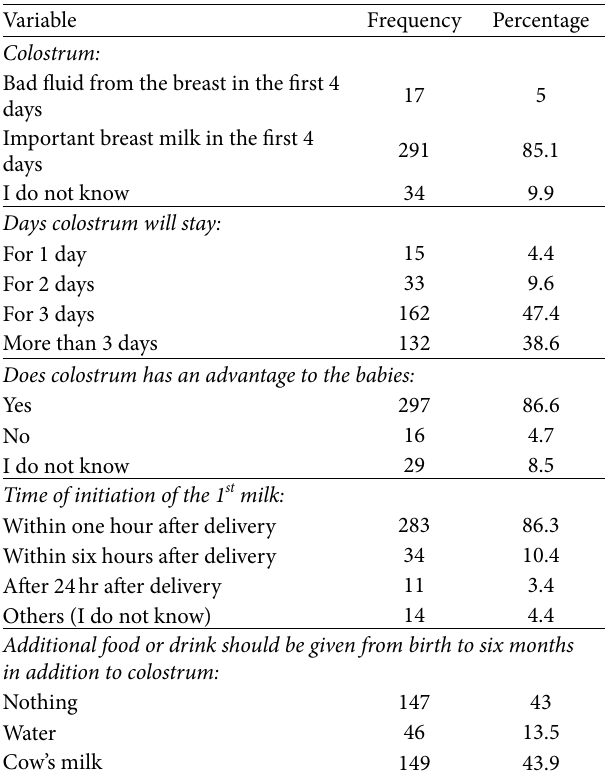
Table 3: Maternal knowledge regarding colostrum feeding in Gununo health center, Wolaita zone, SNNP region, Southern Ethiopia,